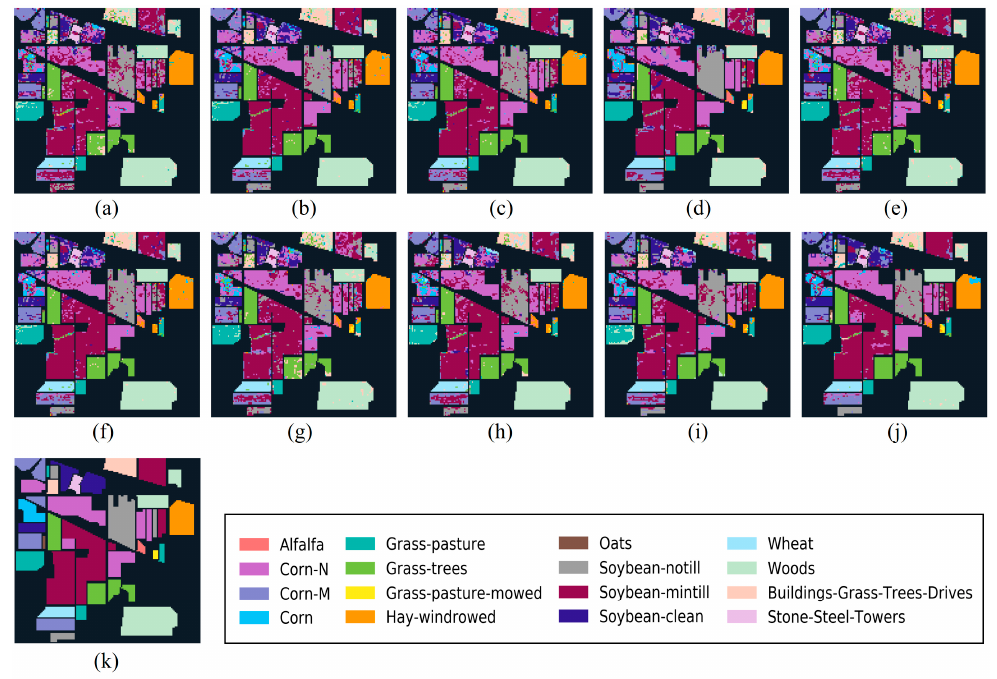
Figure 12. Classification results for Indian Pines. ( a ) Original; ( b ) LRMR; ( c ) NAILRMA; ( d ) NGmeet; ( e ) L1HyMixDe; ( f ) E3DTV; ( g ) LRTDTV; ( h ) HSI-DeNet; ( i ) HSID-CNN; ( j ) ours; ( k ) ground truth and class labels.